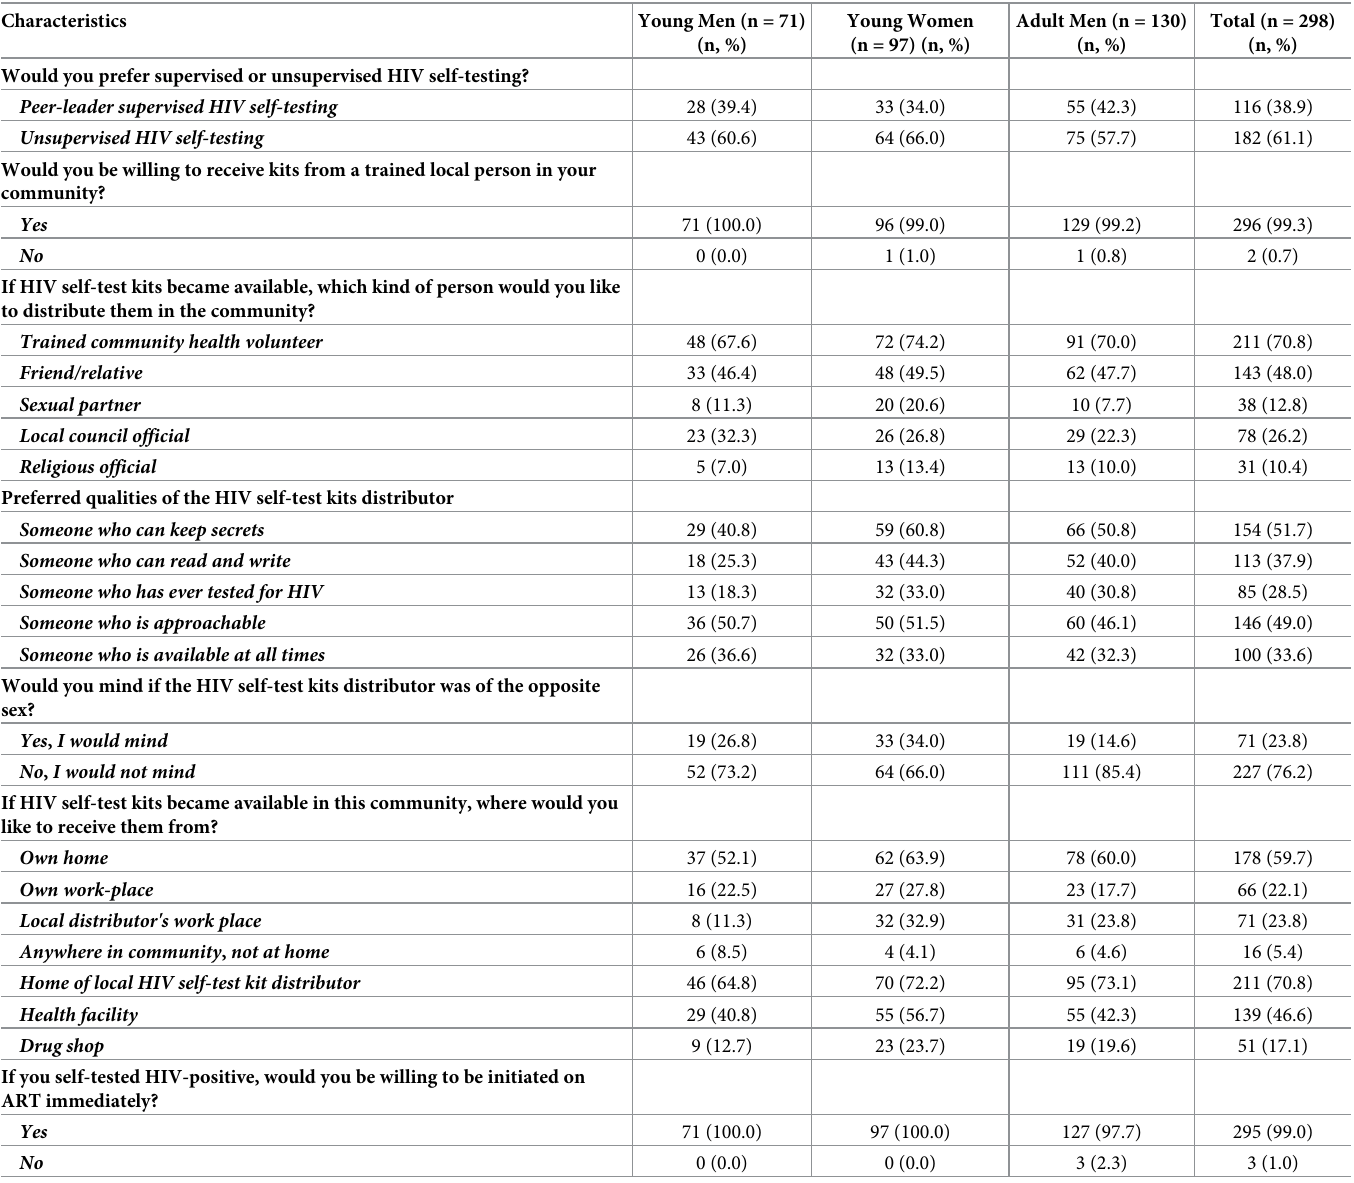
Table 4. HIV self-testing